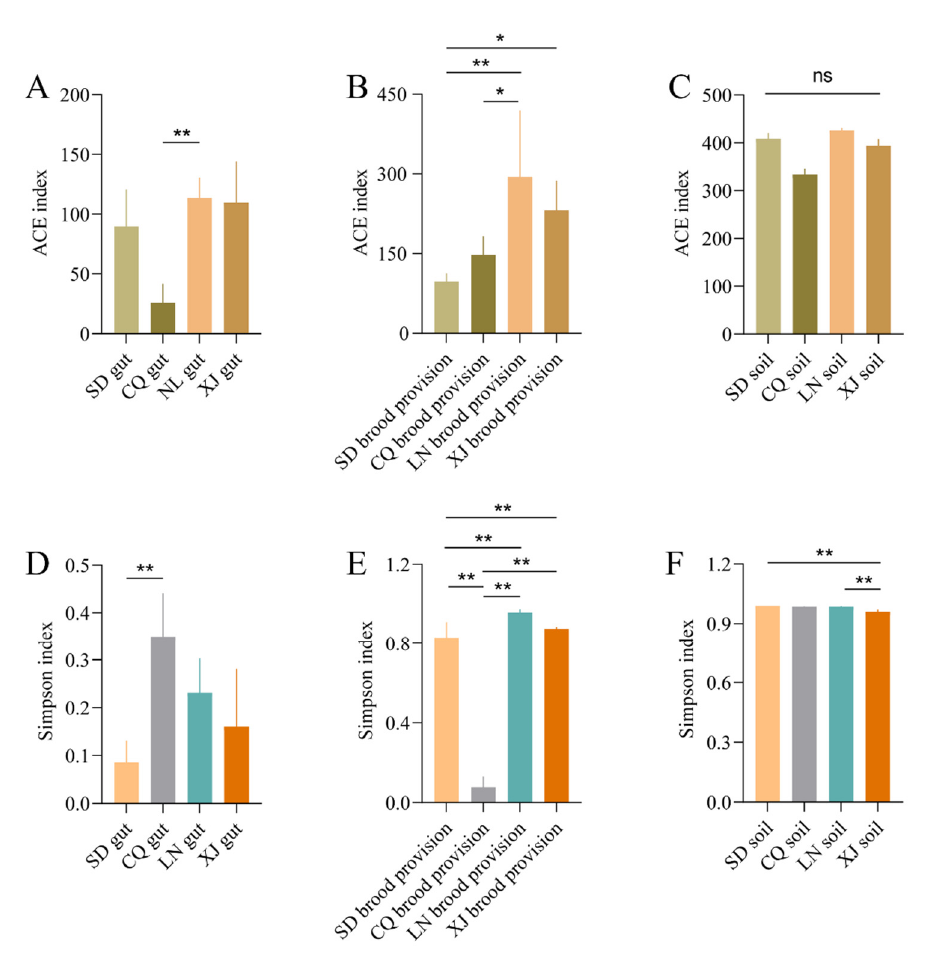
Figure 4. LSD test of the ACE index ( A – C ); and Simpson index ( D – F ) of bacterial communities from the larval guts ( A , D ), brood provisions ( B , E ) and nest soils ( C , F ). Asterisks indicate significant differences between different samples. * p < 0.05, ** p < 0.01. The y-axis and x-axis represent the diversity index value and sample experimental plots, respectively. Table 2. Multiple comparisons of the ACE and Simpson index of larval gut, brood provision, and soil bacteria in different plots.